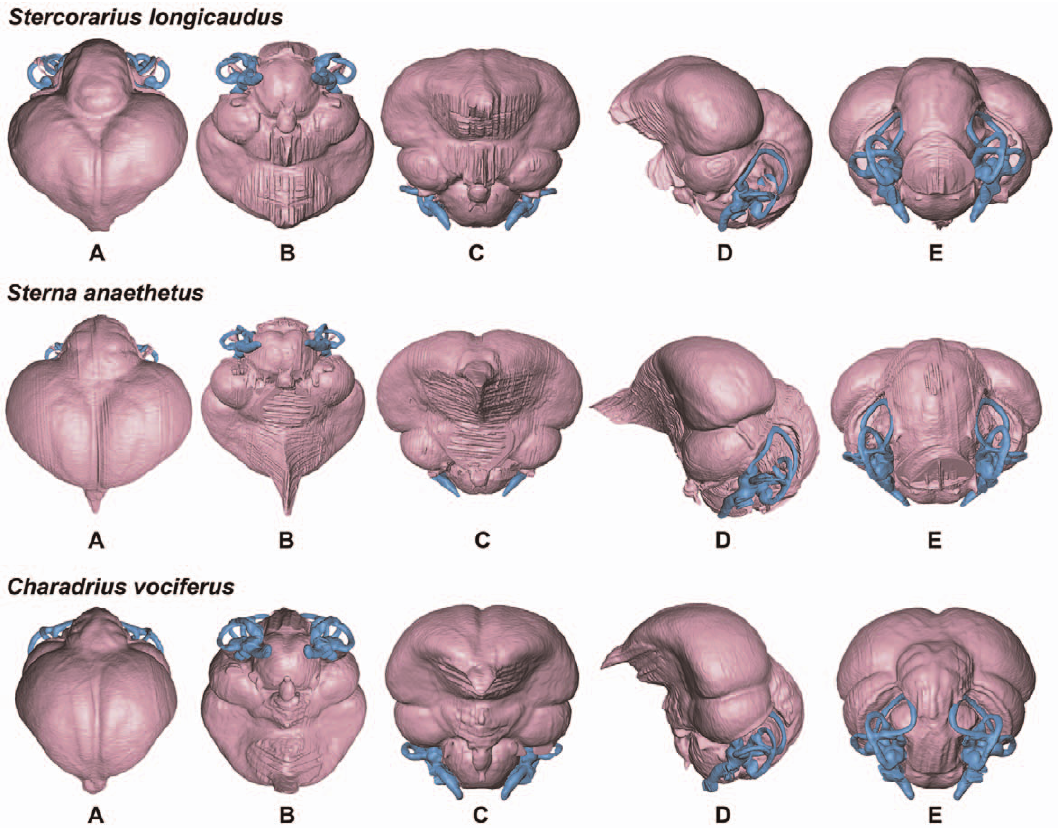
Figure 7. Endocasts of the Long-tailed Skua Stercorariuslongicaudus , Bridled Tern Sternaanaethetus , and Killdeer Charadriusvociferus in dorsal (A), ventral (B), anterior (C), lateral (D), and posterior (E) views (not to scale for comparison).